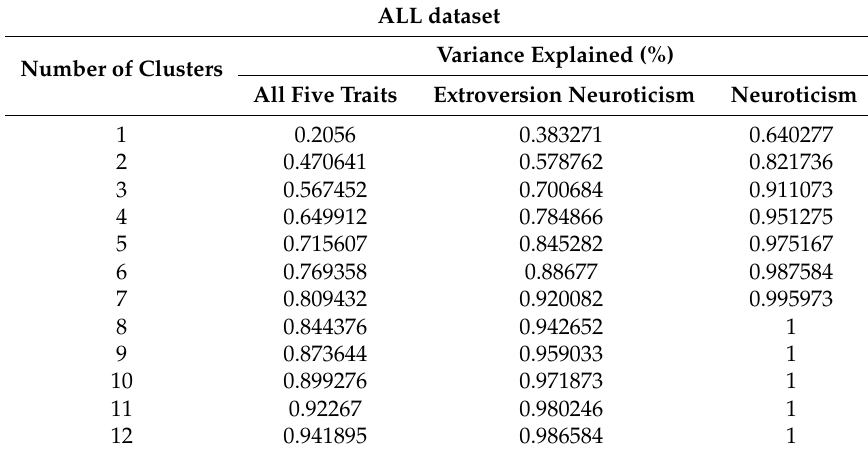
Table 1. Percentage of variance explained based on the number of clusters in AAL data obtained using personality trait scores.